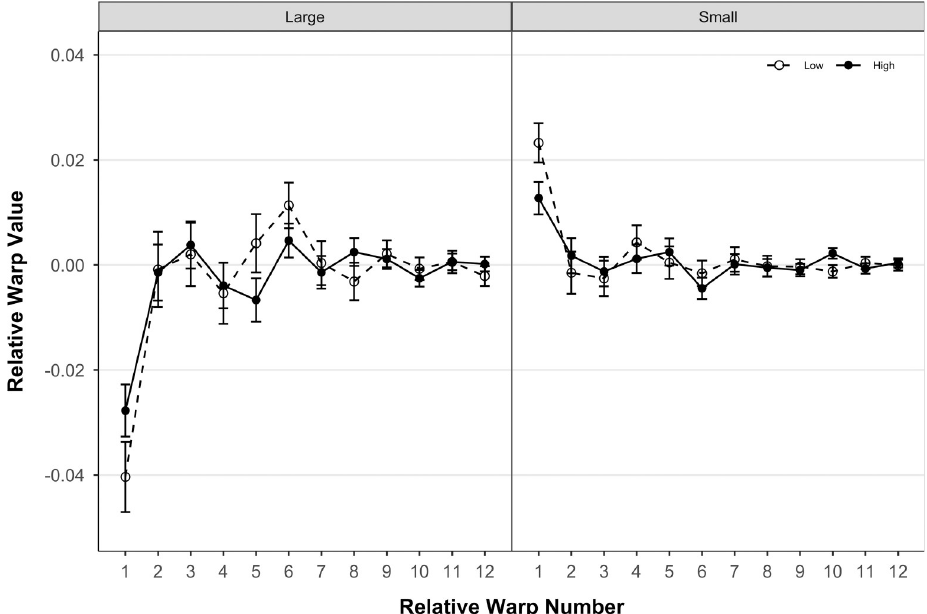
Fig 3. Relative Warp least squares means for body. Least squares means (error bars represent 95% confidence intervals of the mean) for each of 12 relative warps from the multivariate linear mixed model of body shape variation of T . areolatus . High-velocity environment is represented by closed circle symbols and solid connecting lines, and low- velocity environment is represented by open circle symbols and dashed connecting lines. Small and large ontogenetic stages are represented by centroid sizes of 35.00 and 150.00,